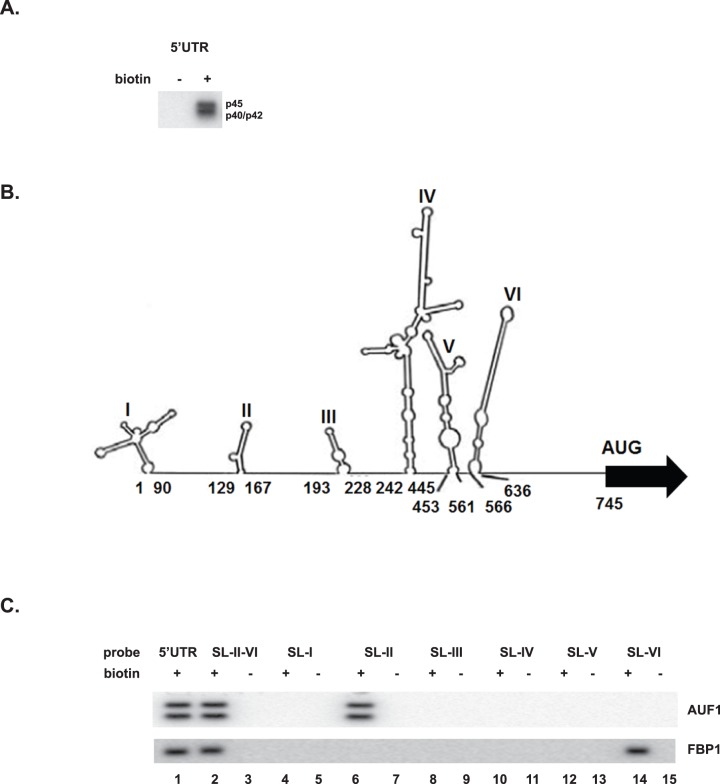
AUF1 interacts with the EV71 5′UTR.(A) RNA-protein pull-down experiments were performed to examine the interaction between AUF1 and the EV71 5′UTR. The EV71 5′UTR was synthesized in vitro in the presence of biotin-UTP. Biotinylated RNA was incubated with SF268 cell lysate (200 µg proteins) for 15 min at 30°C. Unlabeled RNA was added to parallel reactions as a negative control. Streptavidin-linked beads were used to pull-down biotin-labeled EV71 5′UTR and its associated cellular proteins. The beads were washed and then resuspended in SDS-PAGE loading buffer to dissociate proteins from RNA. Samples were boiled and analyzed by Western blot using anti-AUF1 antibody. (B) Secondary structures within the 5′UTR were predicted by MFold. Numbers below each stem-loop indicate 5′UTR nucleotides encompassing the respective stem-loop. RNA substrates used for protein-RNA pull-down experiments contained the indicated stem-loop and the flanking region immediately 5′ to it. (C) Identification of AUF1 interaction site(s) within the EV71 5′UTR. Biotinylated RNAs containing the indicated stem-loops were synthesized; control RNAs lacked biotin. SL-VI extends to nt 745, so it contains linker sequence between the IRES and the AUG. RNA-protein pull-downs and Western blot analysis were carried out as described for panel (A). The blot was stripped and re-probed with anti-FBP1 antibody as a positive control for RNA-binding activity.